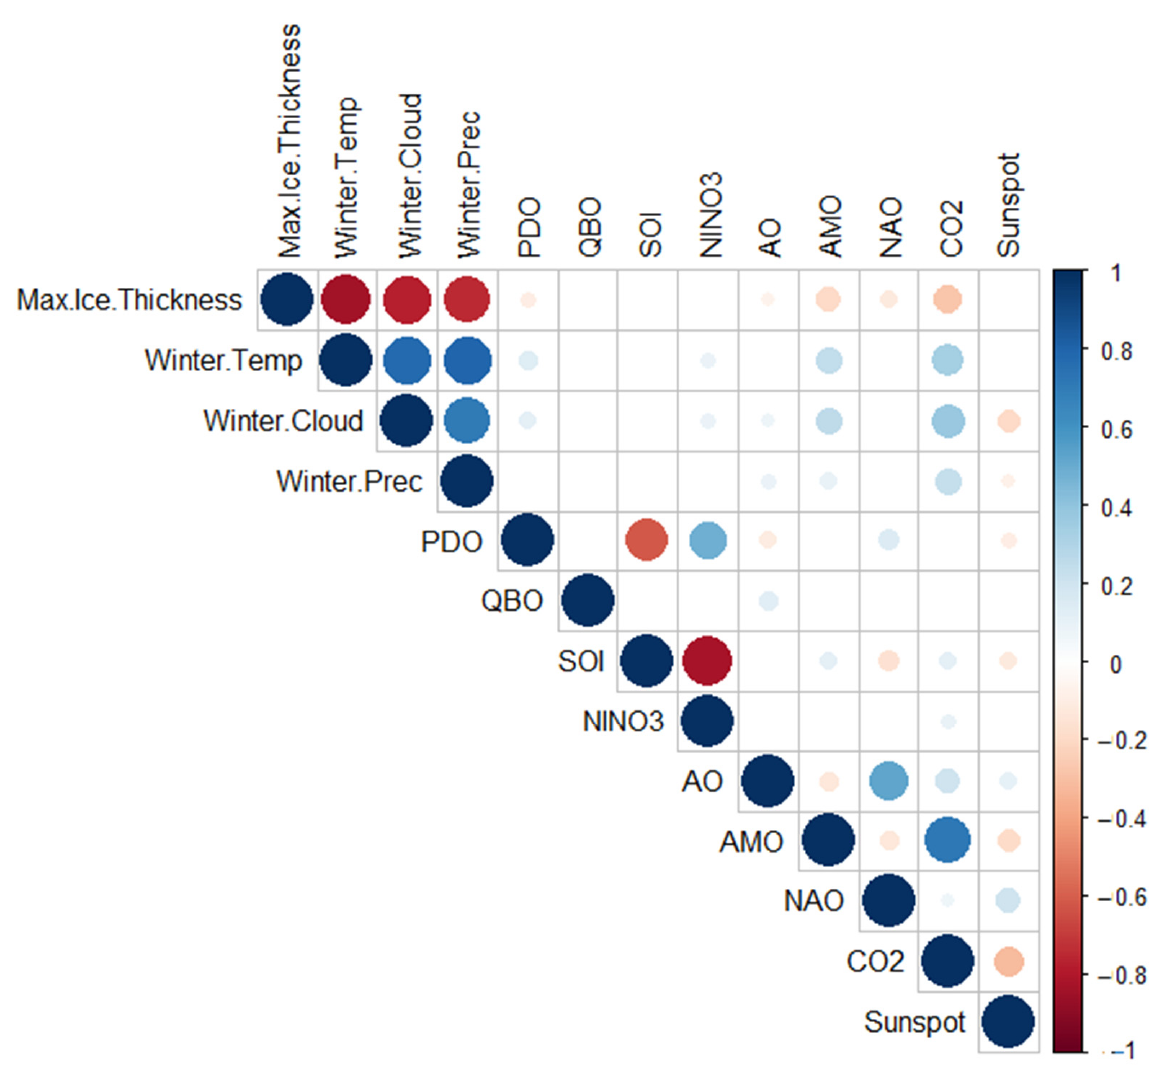
Figure 2. Spearman correlations for drivers affecting maximum ice thickness (cm) of lakes and rivers. The area of the dots and the color intensity are proportional to the strength of correlation of the variables. Positive correlations are represented by cooler colors and negative correlations are represented by warmer colors. Empty grids represent non-significant correlations. Names of variables include: Max.Ice.Thickness: Maximum ice thickness (cm); Winter.Temp: Local winter air temperature, Winter.Cloud: Local winter cloud cover; Winter.Prec: Local winter precipitation; PDO: Pacific Decadal Oscillation; QBO: Quasi-Biennial Oscillation; SOI: Southern Oscillation Index; NINO3: El Nino Southern Oscillation Region 3; AO: Arctic Oscillation; AMO: Atlantic Multidecadal Oscillation; NAO: North Atlantic Oscillation; CO2: Global carbon dioxide (ppm); and Sunspot: Annual sunspot numbers.